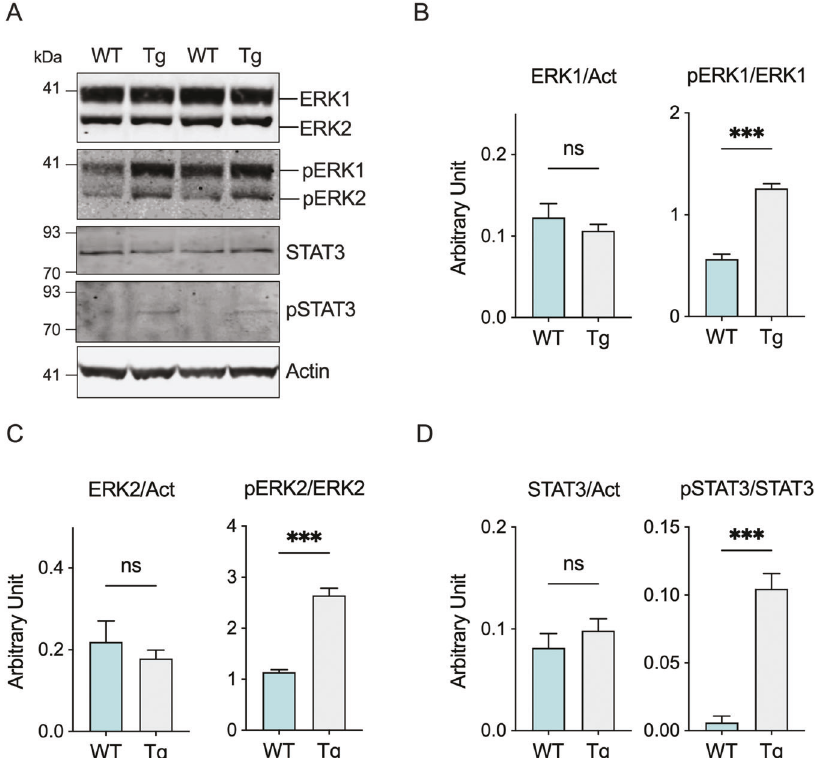
Fig. 5 ERK1/2 signaling is activated in ALS transgenic mice. A Western blot of proteins extracted from spinal cord of wild type and transgenic mice relative to total and phosphorylated ERK1/2 and STAT3. B – D Quantitative analysis of total and phosphorylated ERK1 B , ERK2 C , and STAT3 D . Western blot quanti fi cations of total proteins were performed by normalizing the protein of interest to Actin, while quanti fi cation of phosphorylated proteins were obtained using the relative total protein for normalization. Data are expressed as mean ± SEM of n = 4 independent measurement and statistically analyzed by Student t-test, with *** p < 0.001; ns not signi fi